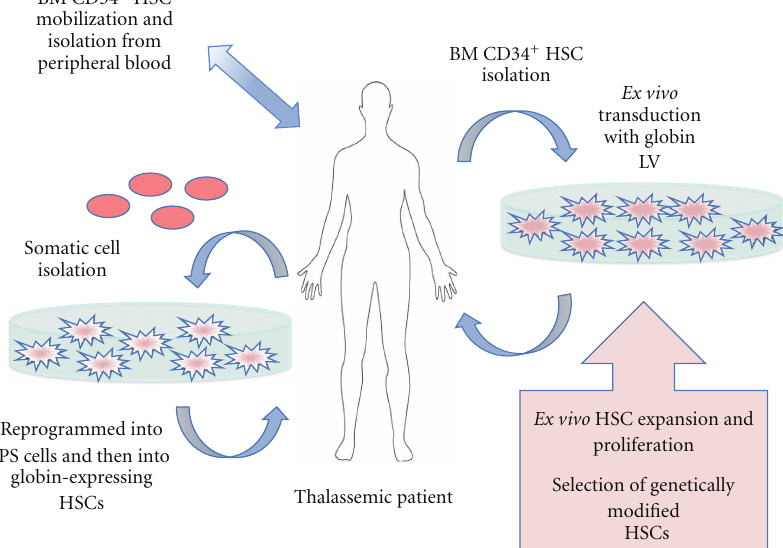
Figure 1: Schematic representation of HSC-based gene therapy for β -thalassemia. BM CD34 + cells are removed from the patient (right panel), transduced in vitro with the therapeutic globin LV, carrying the preferred envelope glycoproteins, and returned to the patient intravenously. At this stage, and primarily in the case of human HSCs, ex vivo expansion and proliferation can be induced; alternatively, selection of genetically modified HSCs may take place. Both strategies can lead to increased yield of corrected HSCs, which will contribute to the HSC compartment, when returned to the patient. Alternative strategies for obtaining higher yield of CD34 + cells are continuously emerging (left panel). These include mobilization of BM CD34 + HSCs with mainly G-CSF and then isolation of these cells from peripheral blood. Moreover, iPS cell strategy suggests that somatic cells from the patient can be reprogrammed to iPS cells and after genetic manipulation, involving genetic correction for the mutations by homologous recombination, these cells can give rise to globin-producing HSCs, following directed hematopoietic di ff